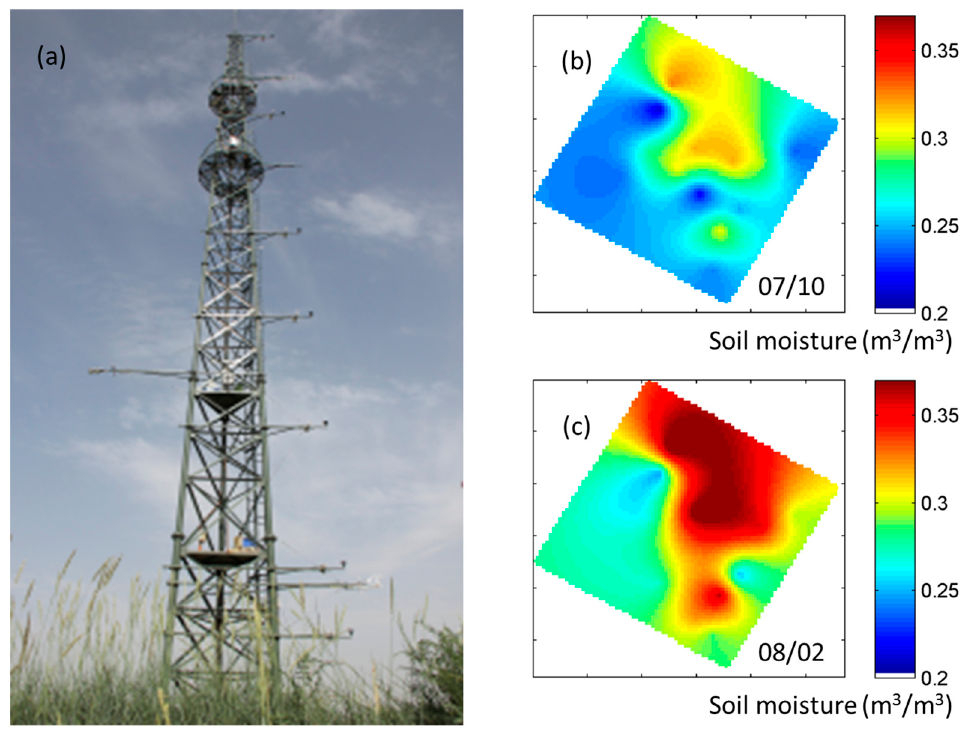
Figure 5. Ground photograph of ( a ) the Daman Super Station located at 100°22’E, 38°51’ N and the spatial distribution of the 0–5 cm soil moisture over the study area as a whole on ( b ) 10 July 2012 and ( c ) 2 August 2012. 0710 stands for 10 July 2012 while 0802 stands for 2 August 2012.